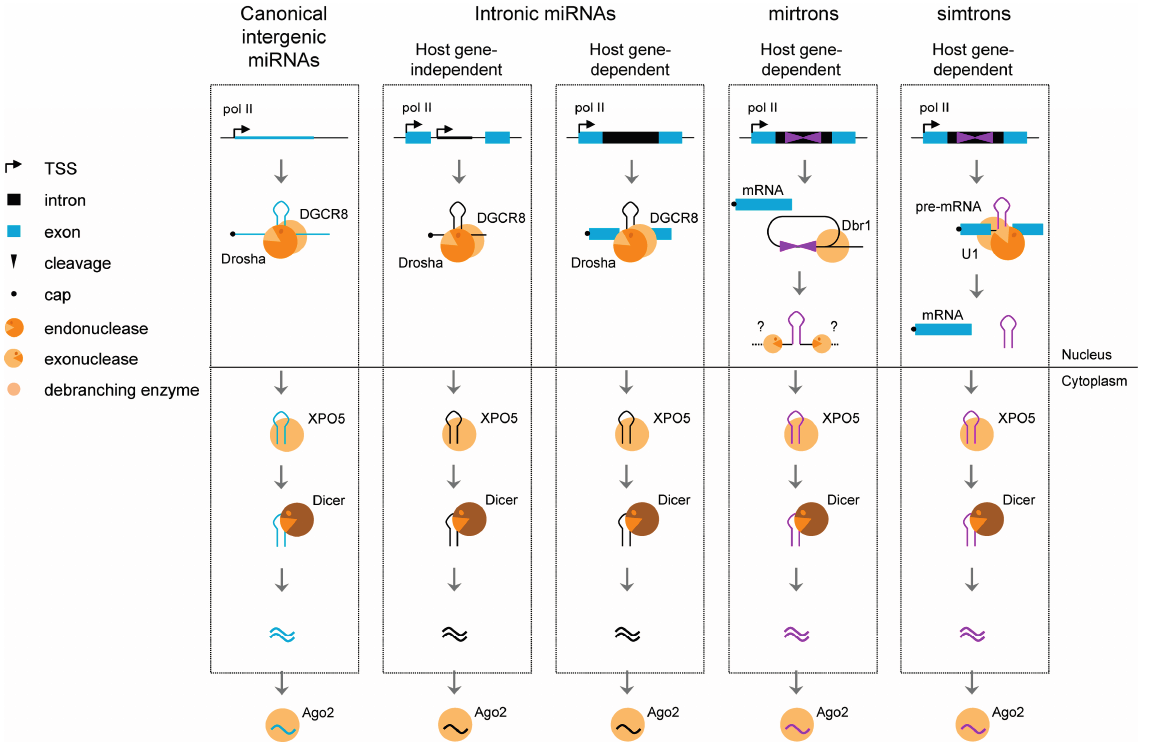
Figure 4. Different mechanisms of microRNA biogenesis. The first three panels correspond to the canonical miRNA pathway, either intergenic (miRNAs) or intronic (intronic miRNAs), and the last two panels represent new alternative pathways, either independent of the microprocessor Drosha/DGCR8 (mirtrons) or independent of DGCR8 but dependent of U1 snRNP (simtrons), both dependent on splicing to produce miRNAs. DGCR8 stands for DiGeorge syndrome critical region gene 8. Adapted from